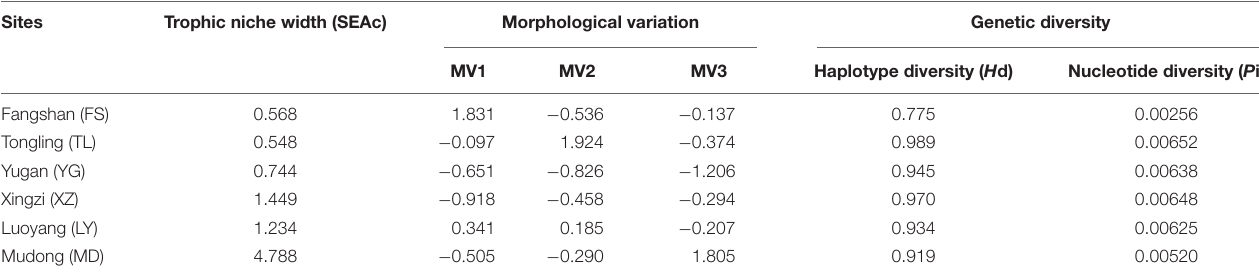
TABLE 3 | Trophic niche width, morphological variation (MV1, MV2, and MV3 refers to PC1, PC2, and PC3 scores, respectively), and genetic diversity (haplotype diversity and nucleotide diversity) of H. leucisculus in the studied populations. Sites Trophic niche width (SEAc) Morphological variation